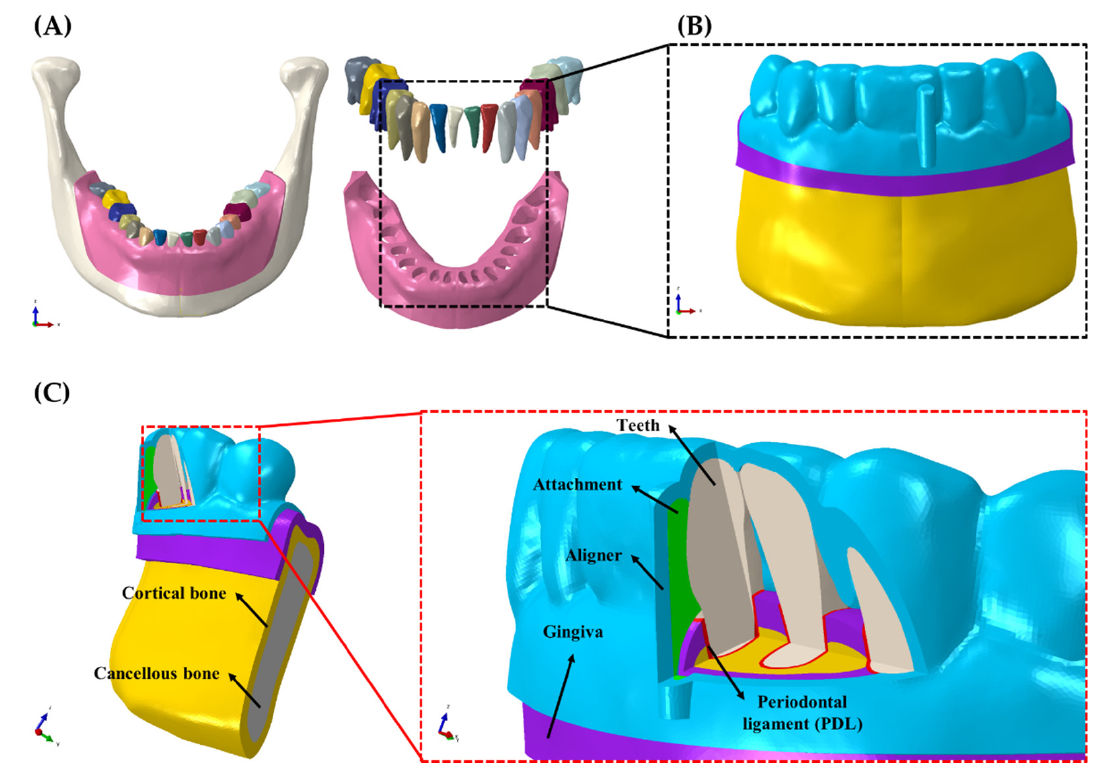
Figure 1. A 3D FE creation process in the orthodontic treatment situation. ( A ) Bone, gingiva and teeth segmentation from 3D CBCT data; ( B ) 3D orthodontic FE model. ( C ) Component of 3D orthodontic FE model.